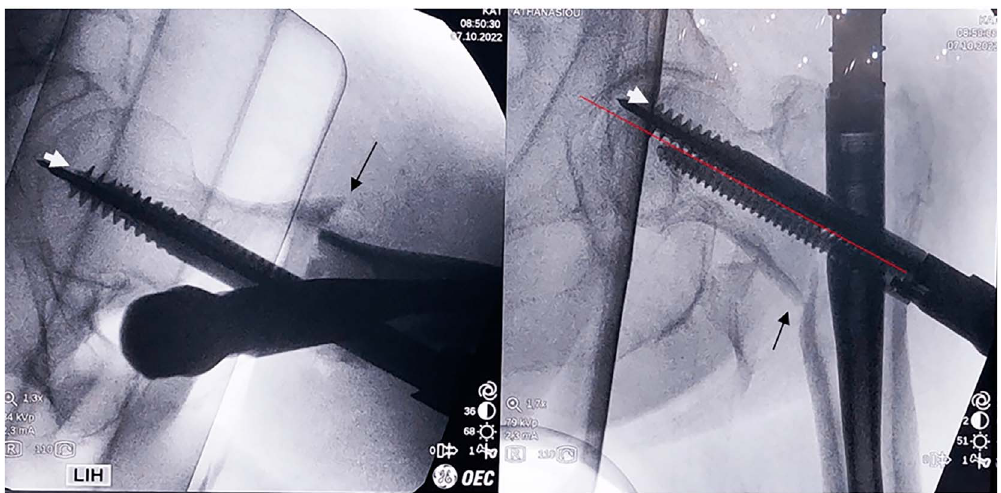
Figure 5. Final images depicting the ultimate reduction of the fracture gap at the maximum (15 mm) desirable measure, with optimal TAD and a double compression